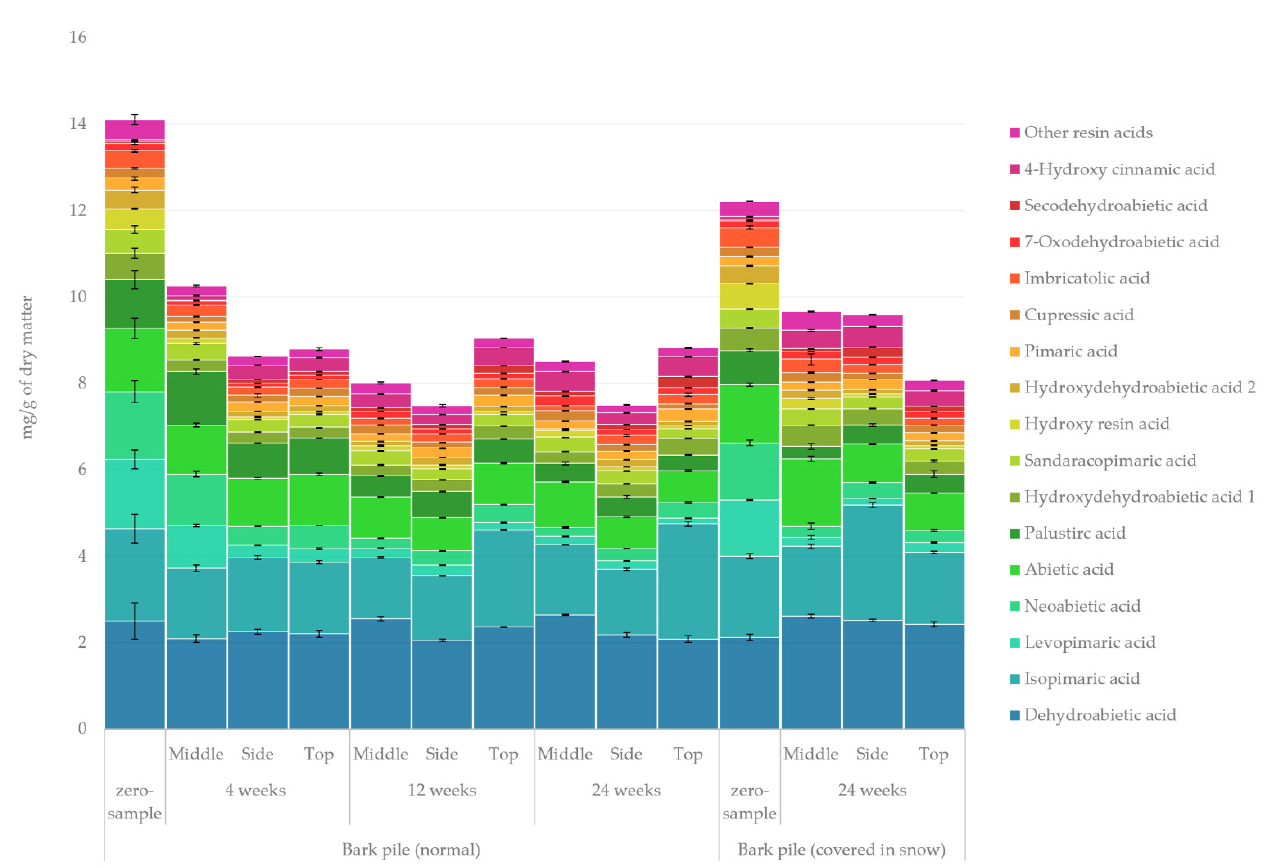
Figure 5. Quantified amounts of individual resin acids in the lipophilic extracts of stored